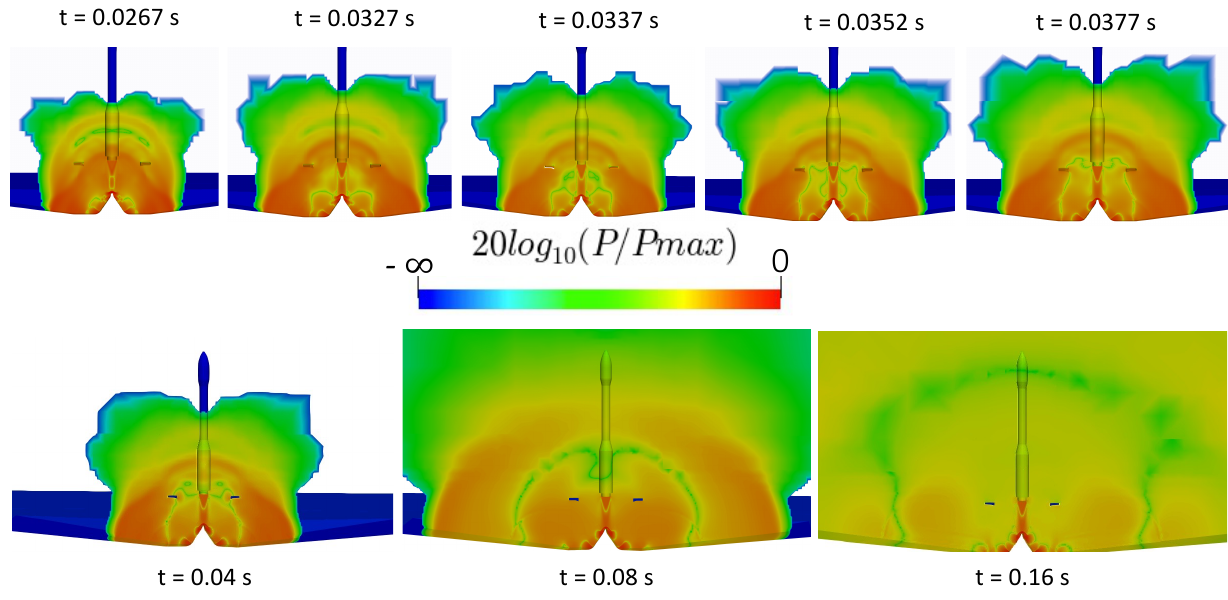
Figure 5. Normalized instantaneous pressure contour of VEGA launch pad